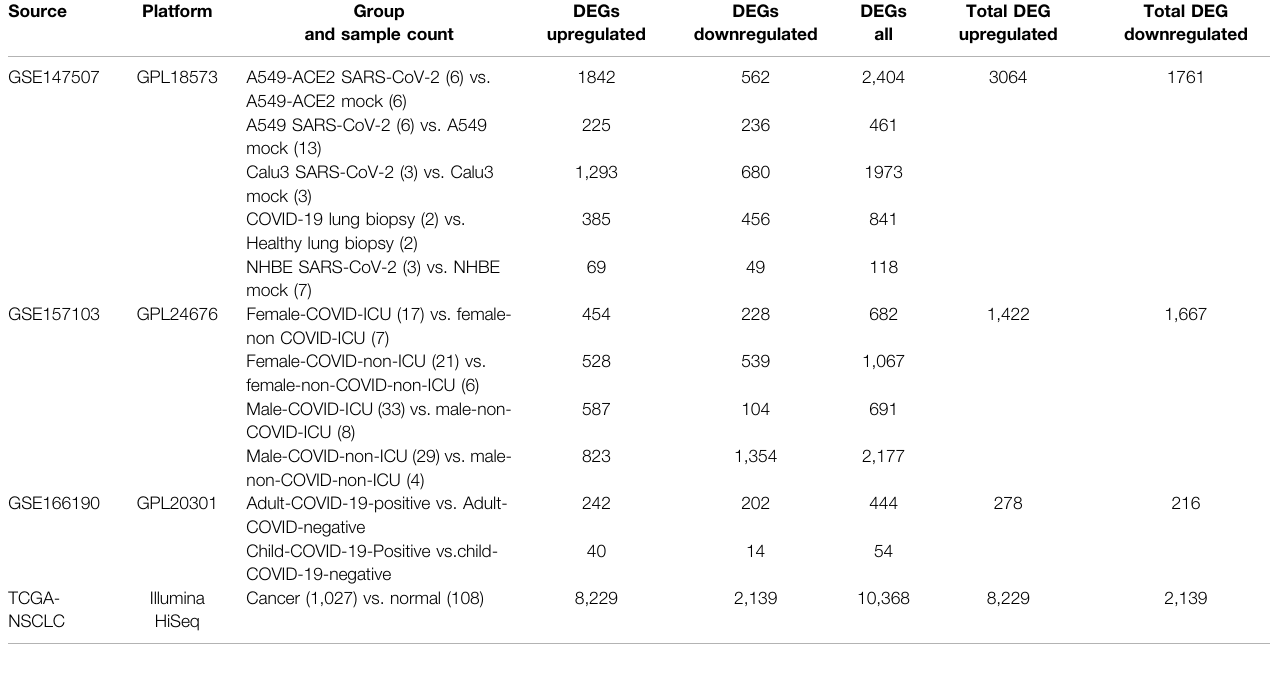
TABLE 1 | DEGs in different RNA-seq datasets.